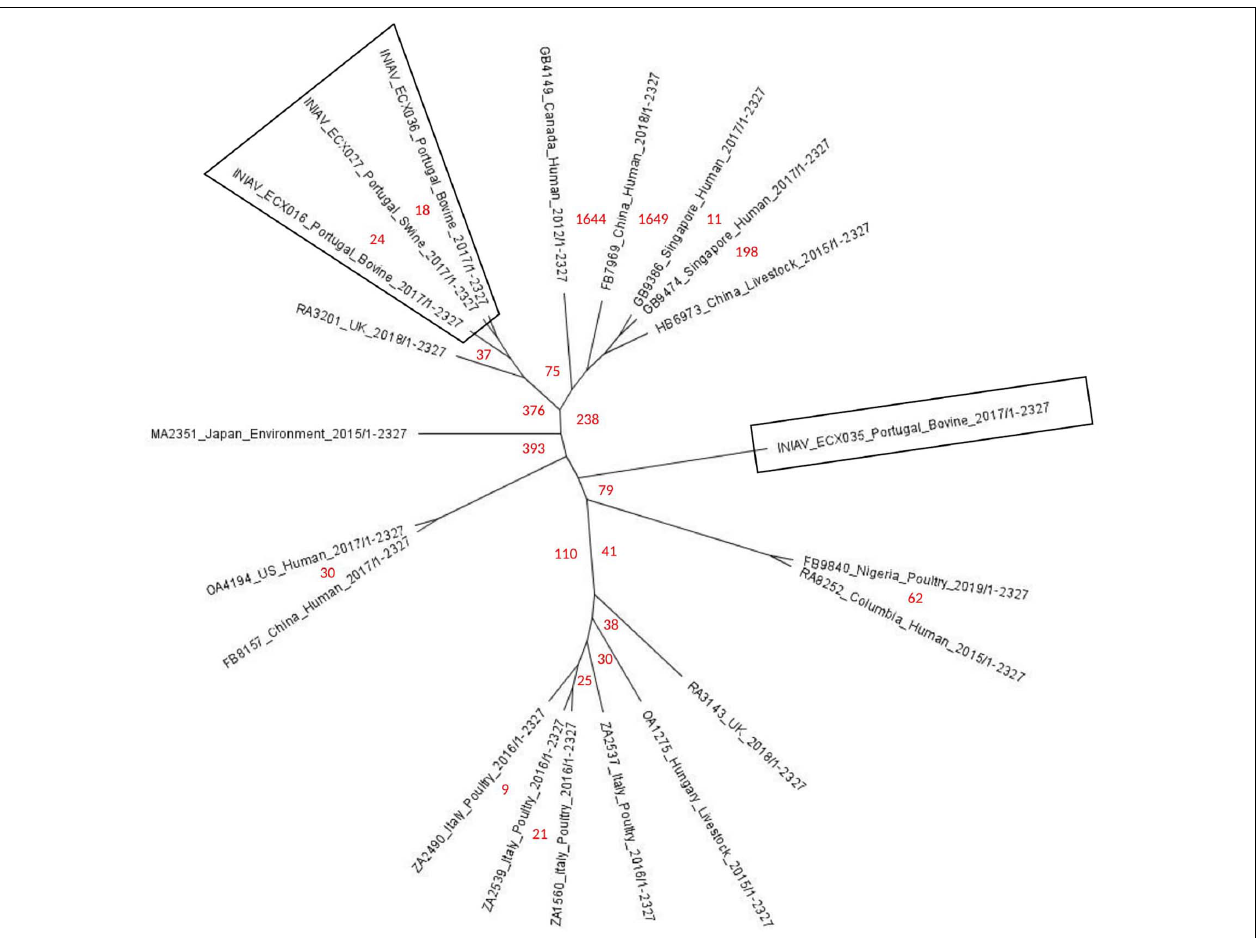
FIGURE 3 | Phylogenetic tree of the 21 ST2179 Escherichia coli strains harboring the bla CTX − M − 65 gene generated by single nucleotide polymorphism (SNP) analysis using the CSIPhylogeny tool and visualized with FigTree (unrooted radial cladogram options). Numbers in red represent the number of SNPs between the strains from distinct geographic regions and sources. Portuguese strains are inside boxes